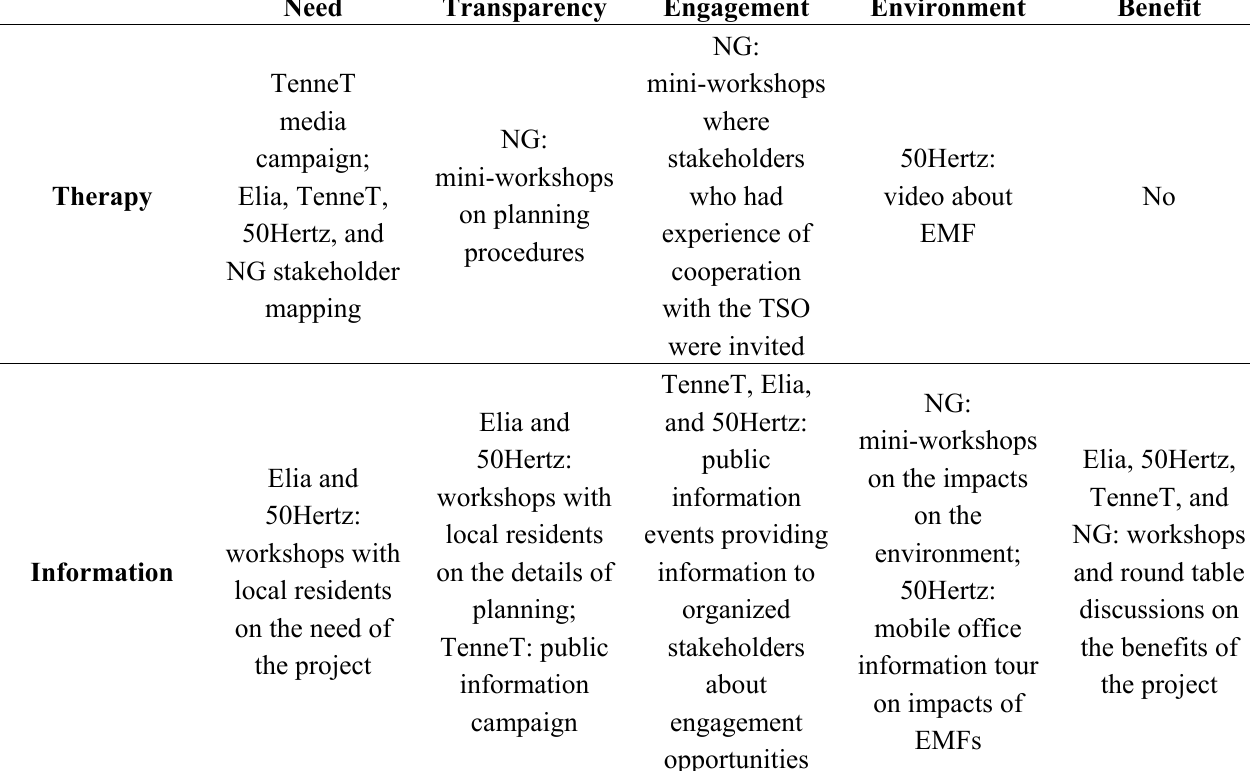
Table 1. Actions within four pilot projects, according to Arnstein’s